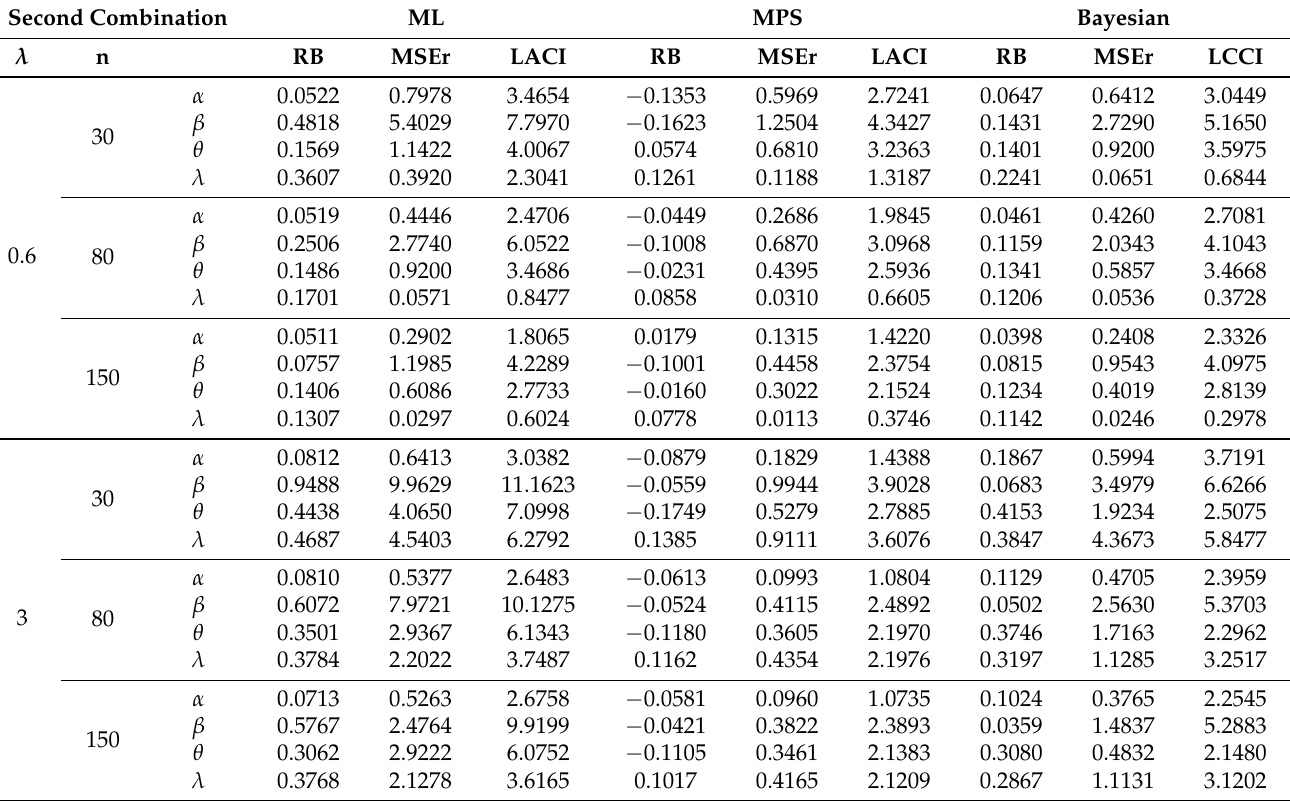
Table 5. ML, MPS, Bayes estimation methods: RB, MSE, LACI and LCCI at second combination.